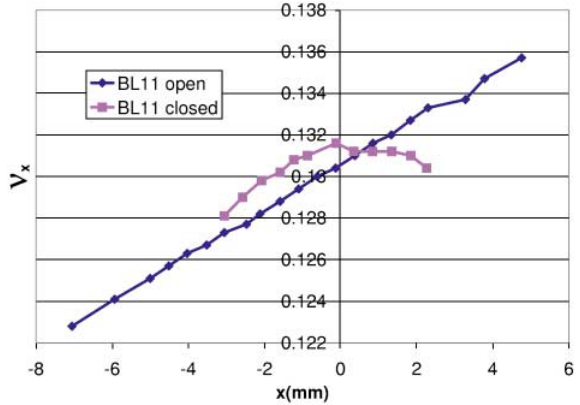
FIG. 4. (Color) Tune vs closed orbit bump in BL11 without magic fingers.